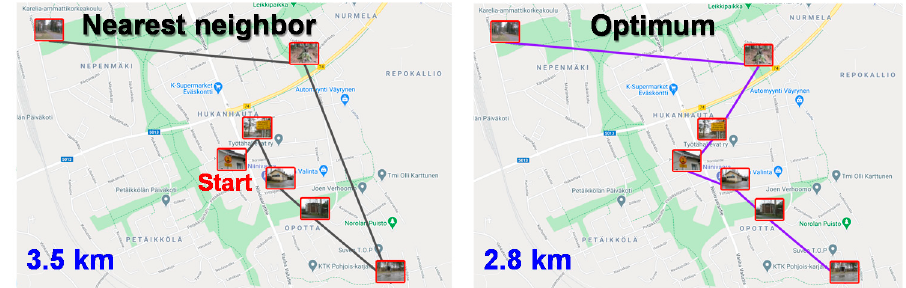
Figure 3. Nearest neighbor algorithm easily fails if unlucky with the selection of starting point.